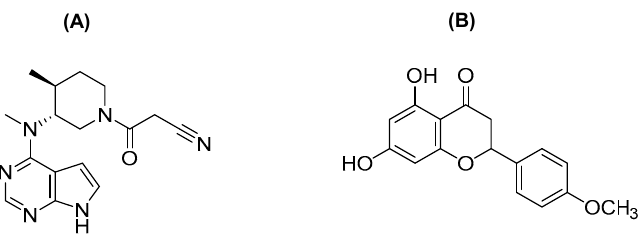
Figure 1. Chemical structure of tofacitinib ( A ) and isosakuranetin ( B ).